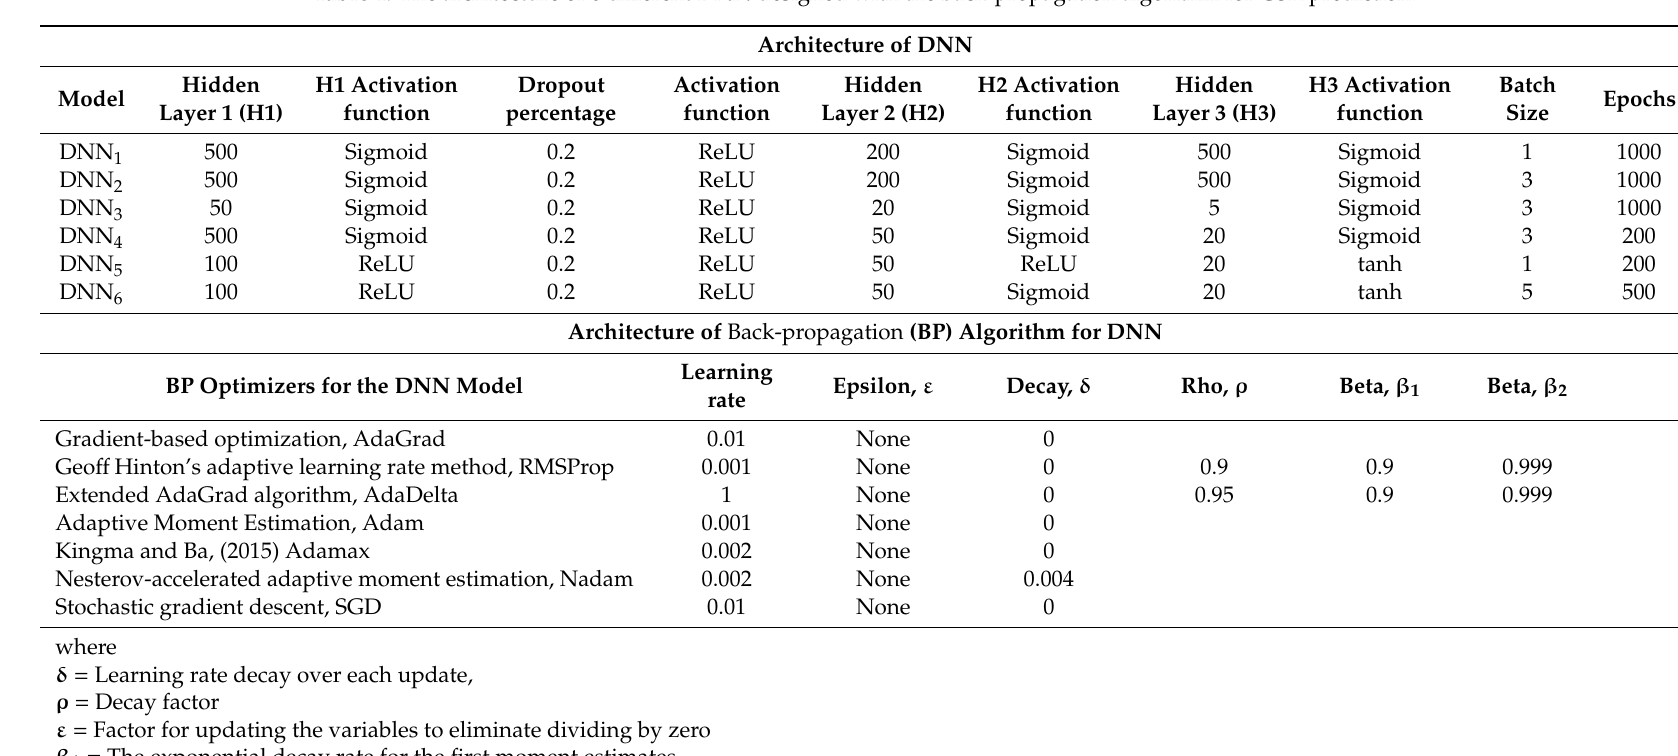
Table 4. The architecture of 6 di ff erent DNN designed with the back-propagation algorithm for GSR prediction.